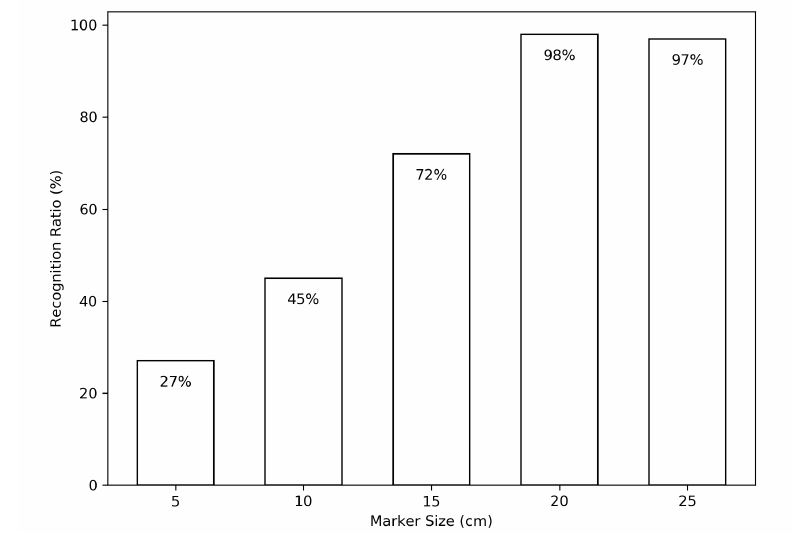
Figure 10. Marker recognition test.